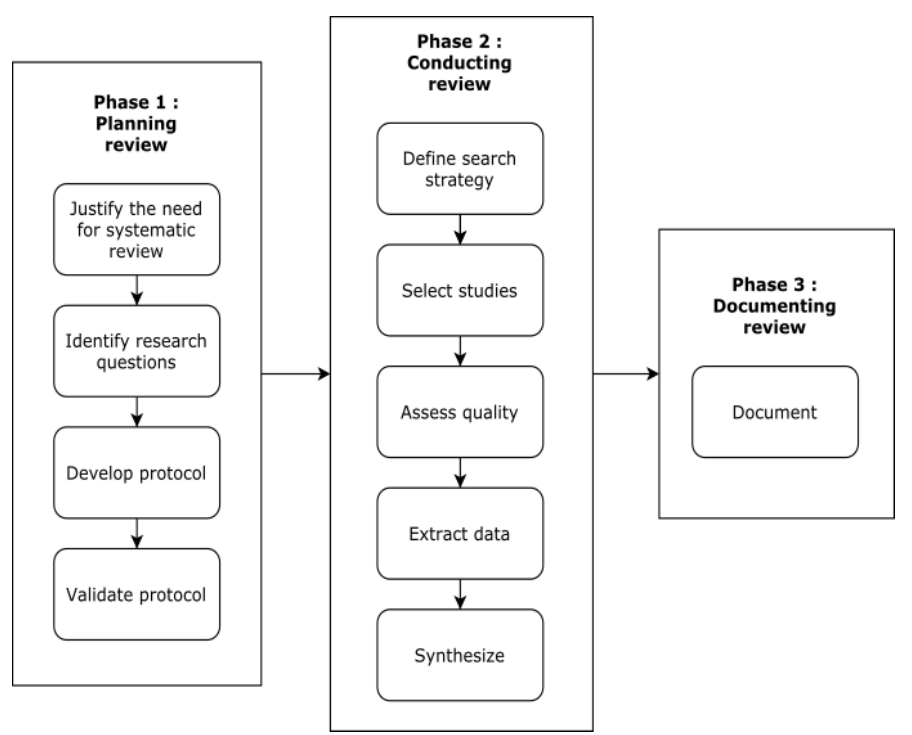
Figure 1. Review protocol (adapted from Kitchenham et al. [36]).